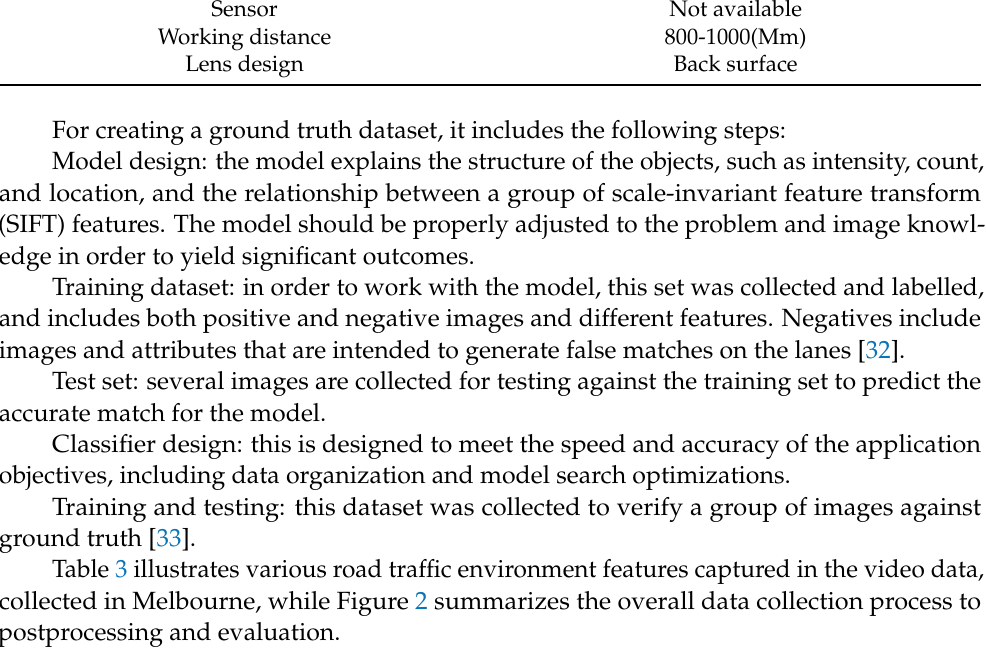
Table 3. Road traffic environment features captured in the video data